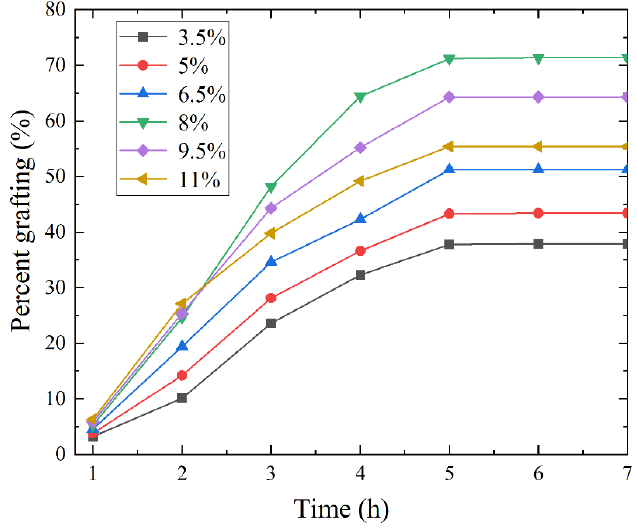
Figure 7. Effect of different initiator dosages on the grafting ratio.